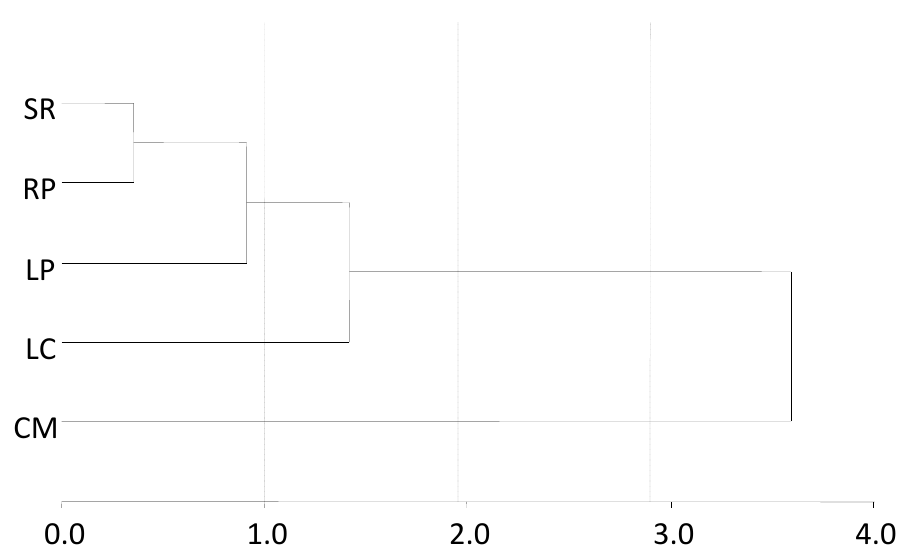
Figure 2. Tree diagram obtained by cluster analysis of glyphosate and aminomethylphosphonic acid (AMPA) quantified in water, sediment and suspended particulate matter samples from the Suquía River basin, using the average linkage method with Euclidean distance. LC: La Calera, CM: Villa Corazón de María, RP: Río Primero, SR: Santa Rosa de Río Primero, LP: La Para.